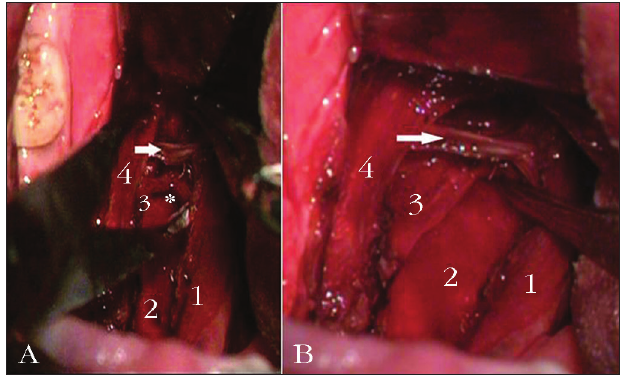
Figura 1. A: (sem tração medial do palatofaríngeo). Aspecto intra - operatório da faringoplastia lateral com preservação do músculo estilofaríngeo. 1: m. palatofaríngeo; 2: fáscia bucofaríngea; 3: m. esti - lofaríngeo; 4: m. palatoglosso; * cruzamento do m. estilofaríngeo com o constritor médio; Seta: m. constritor superior. B: (com tração medial do palatofaríngeo) Aspecto intraoperatório da faringoplastia lateral com preservação do músculo estilofaríngeo. 1: m. palatofaríngeo; 2: fáscia bucofaríngea; 3: m. estilofaríngeo; 4: m. palatoglosso; * cruzamento do m. estilofaríngeo com o constritor médio; Seta: m. constritor